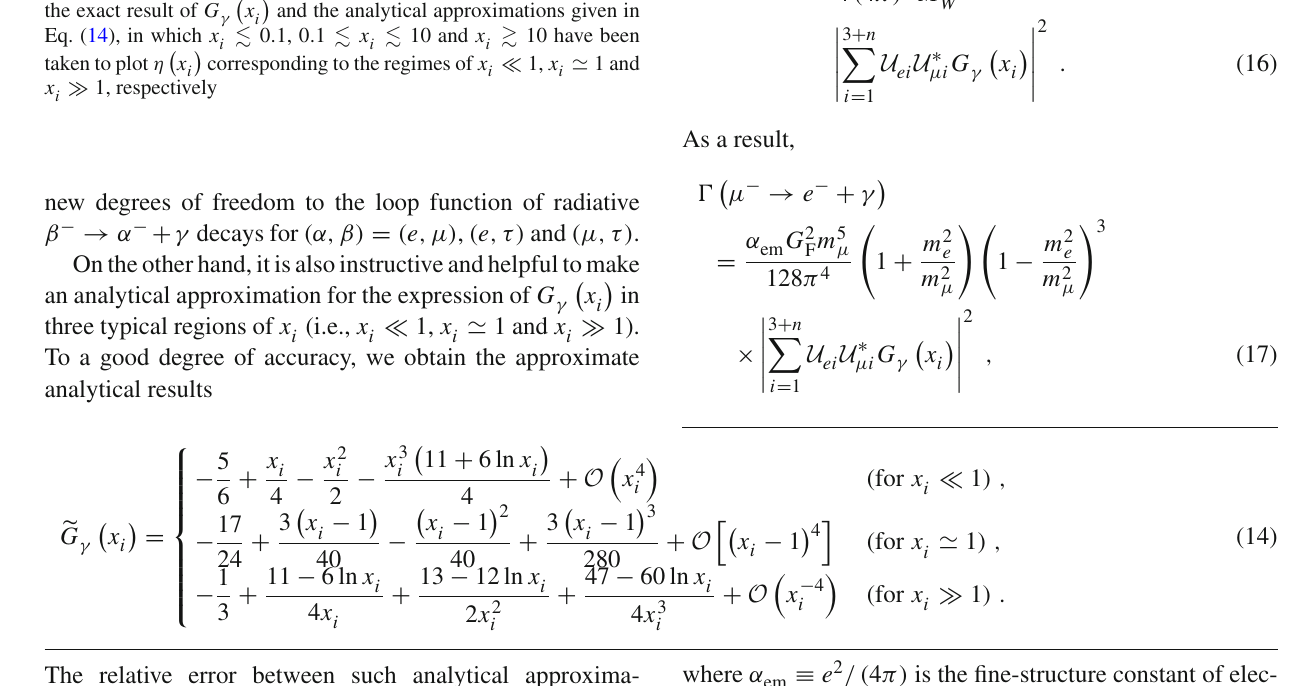
(cid:2) 10 and x i